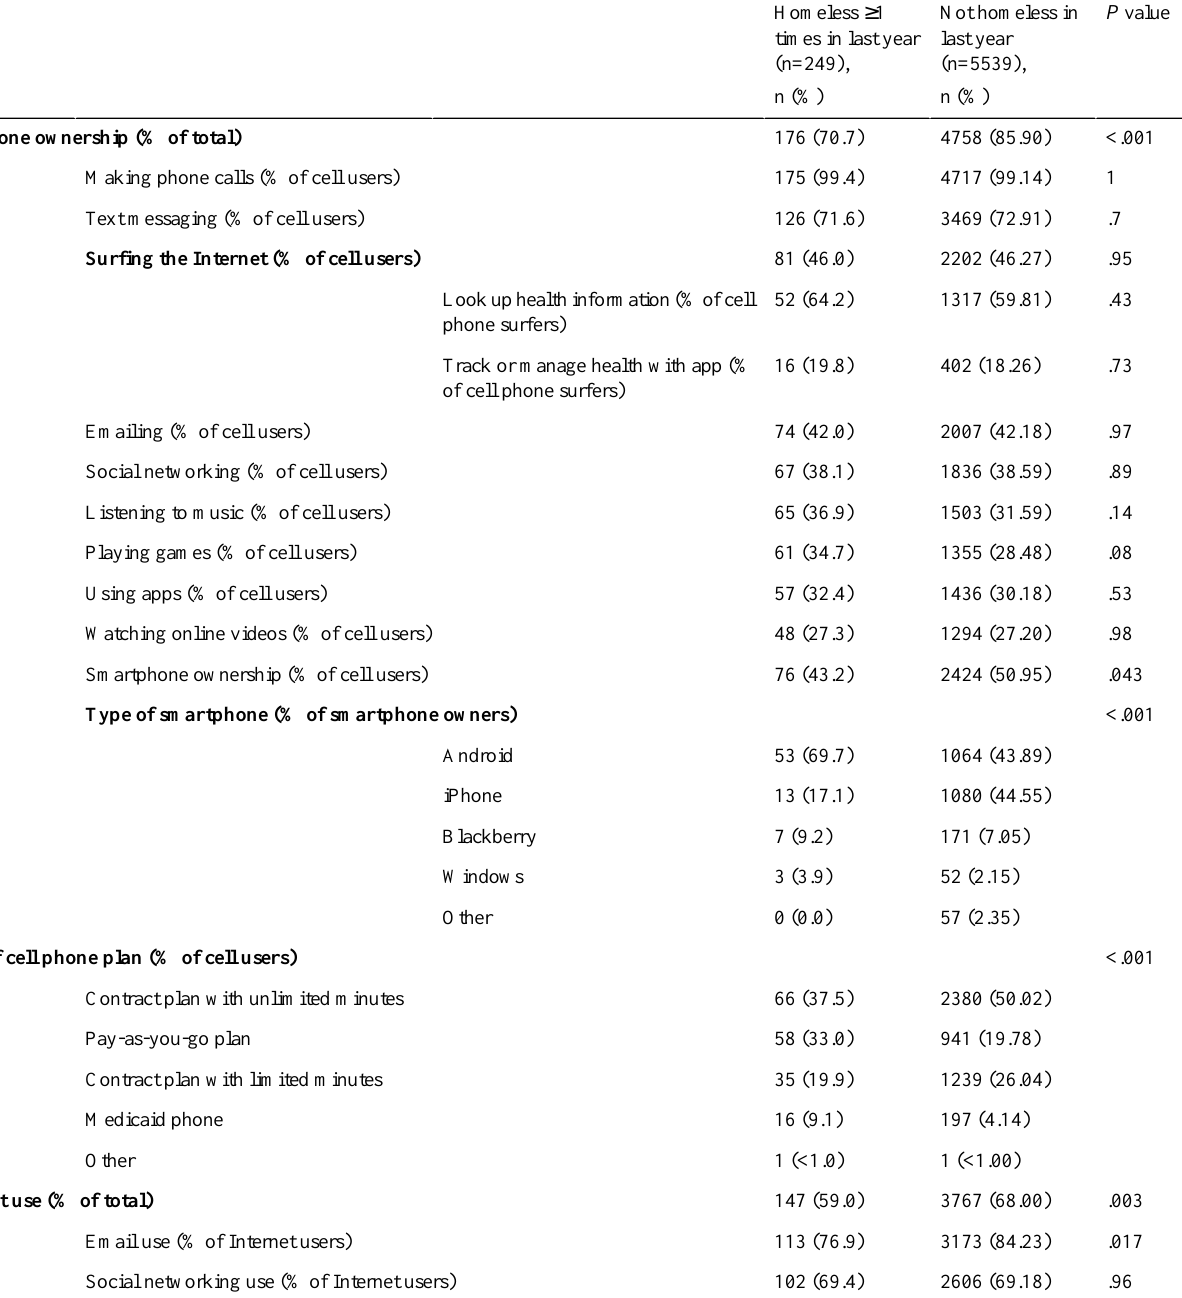
Table 2. Media usage by ED patients experiencing